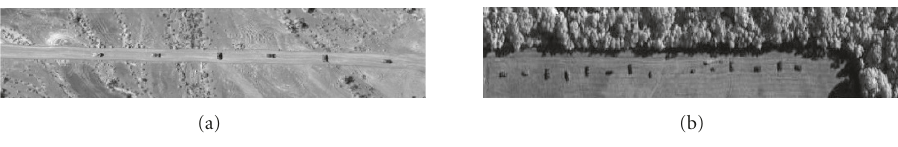
Figure 3: Sample band images from (a) the DR-II image and (b) the FR-I